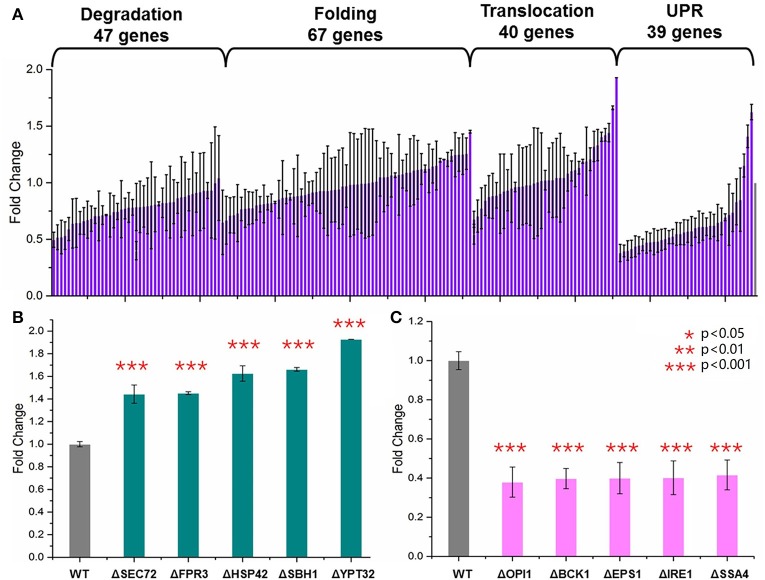
Screening of the yeast knockout collection. (A) Overview of the screening results. Totally 194 S. cerevisiae strains harboring the HBsAg-GFP plasmid were cultured at 30°C for 48 h in SC medium shaken at 250 rpm. The plate reader was used to measure the OD600, and the green florescence with exciting wavelength at 488 nm and the emission wavelength at 509 nm. Each data point represented the mean of biological triplicates and the fluorescence was normalized by OD600. The error bars corresponded to standard deviation. Student's t-test was used to calculate the p-values and we considered two samples were statistically different if p < 0.05. (B) The five knockout strains leading to the highest HBsAg expression. (C) The five knockout strains leading to the lowest HBsAg expression. The p < 0.001 was marked with three asterisks; p < 0.01 was marked with two asterisks; and p < 0.05 was marked with one asterisk.